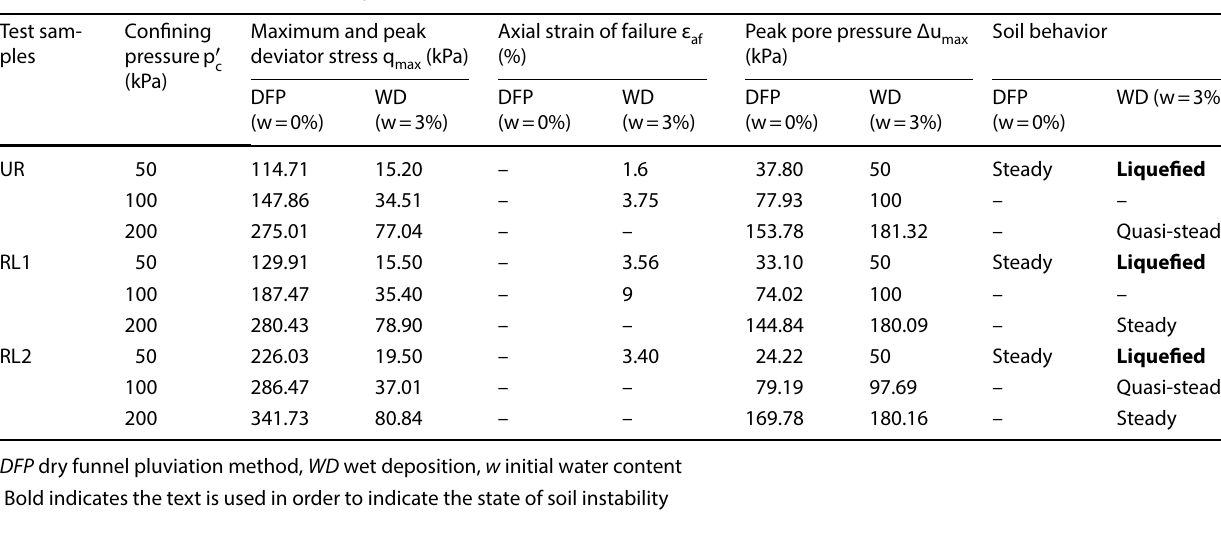
Table 4 Results of undrained triaxial compression tests